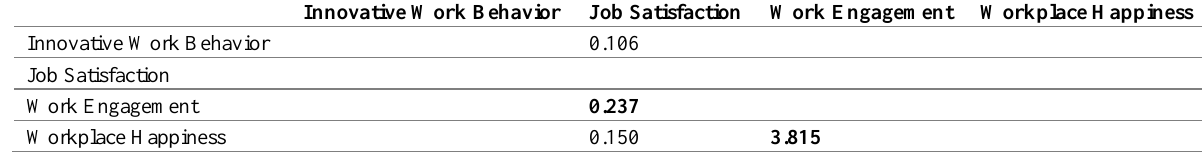
Table 6: Test Results of Effect Size (f-Square)